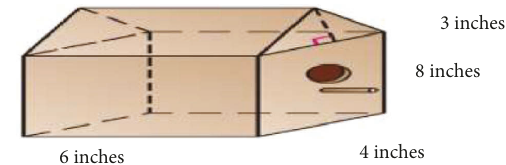
Figure 3: A cage for small birds using GeoGebra